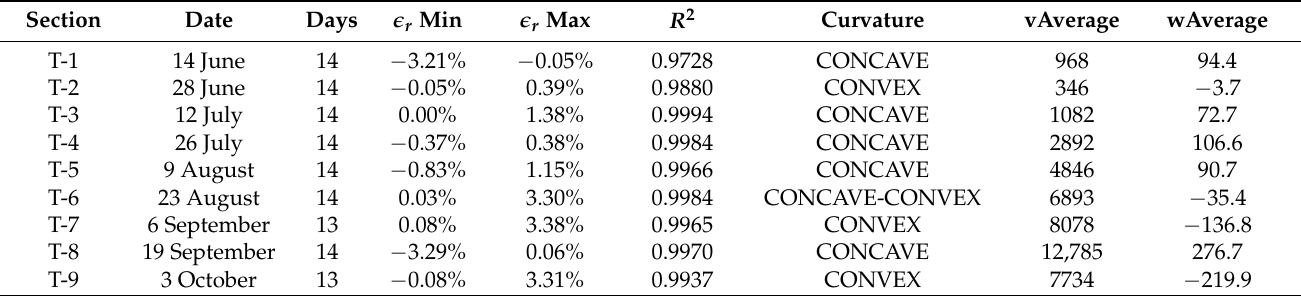
Table 1. Characteristics of the sections of the standard prediction, using arcs of cubic curves, indicating for each one the date on which it was constructed, the duration in days, the relative error ( e r ) range, the coefficient of determination ( R 2 ), the curvature, the average velocity of propagation (v), and the average acceleration